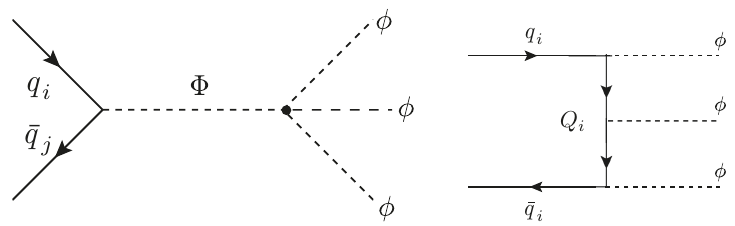
Figure 2 . The SMEFT operator O qφ can be generated either by a new scalar Φ (left) or a new set of VLQs Q (right). When these fields are integrated out, they yield the aforementioned operator in i the unbroken